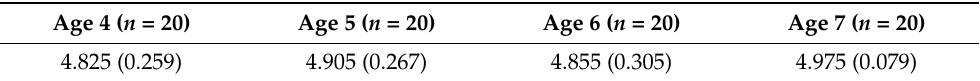
Table 4. Mean and standard deviation (in parentheses) of the intelligibility scores produced by each age